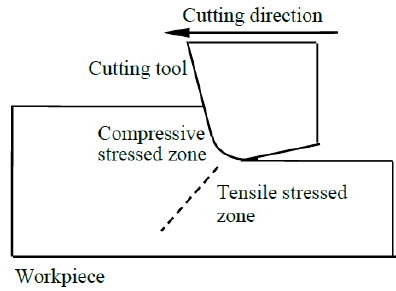
Figure 1. Schematic drawing of stress states in orthogonal cutting.